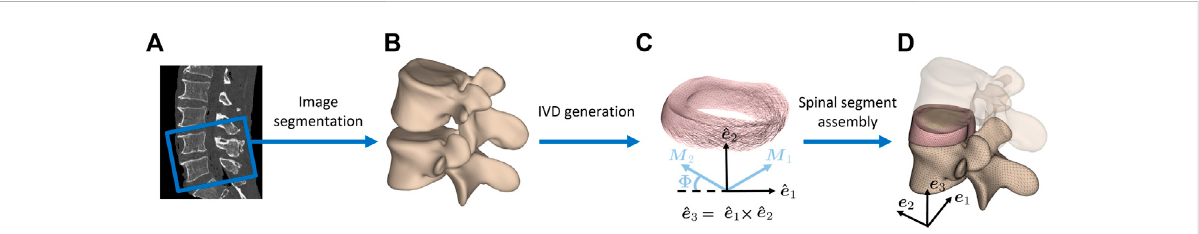
FIGURE 1 Finite element model generation of lumbar spine segments. (A) CT images of human cadaveric spines were used to obtain (B) vertebral 3D modelsthroughsegmentation. (C) Theendplatesoftheresultingvertebralsurfaceswereusedtocreatetheintervertebraldiscgeometryinbetween. Local collagen fi ber directions M 1 and M 2 of the AF are displayed. { e 1 , e 2 , e 3 } and { ^ e 1 , ^ e 2 , ^ e 3 } are respectively the global and local orthonormal bases. (D) Finally, the components of the spinal segment were assembled into one FE model composed of bony and soft tissue (translucent upper vertebra for illustration purposes only).